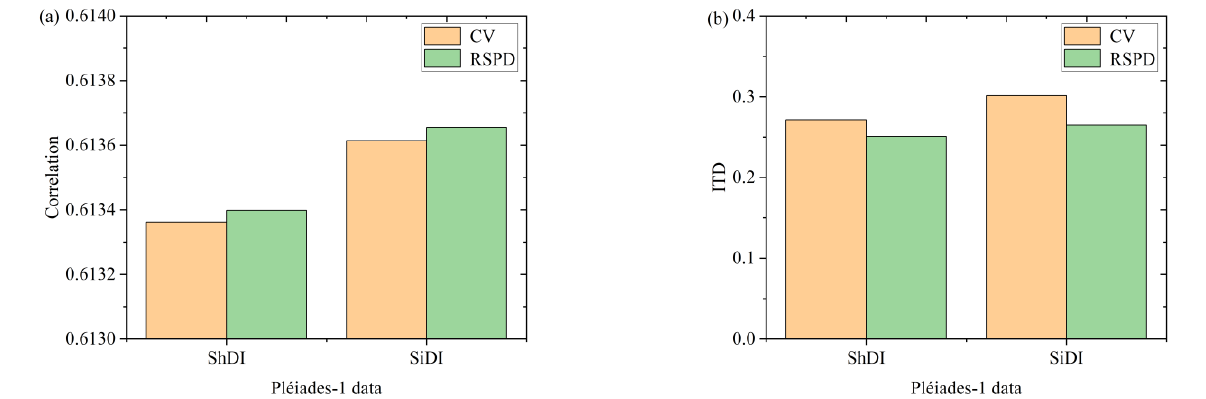
Figure 8. Correlation and ITD between different methods and Pléiades -ShDI/SiDI, respectively (( a ) is the correlation result and ( b ) is the ITD result).